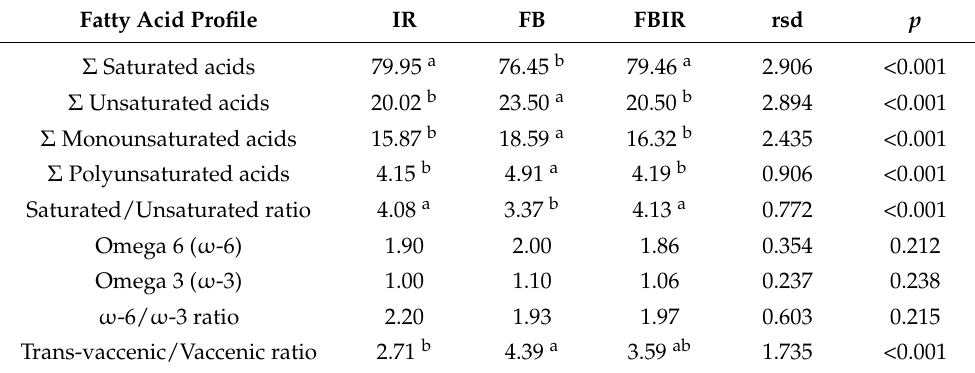
Table 8. Sum of fatty acids (g 100 g − 1 FA) according to the number of double bonds and fatty acid